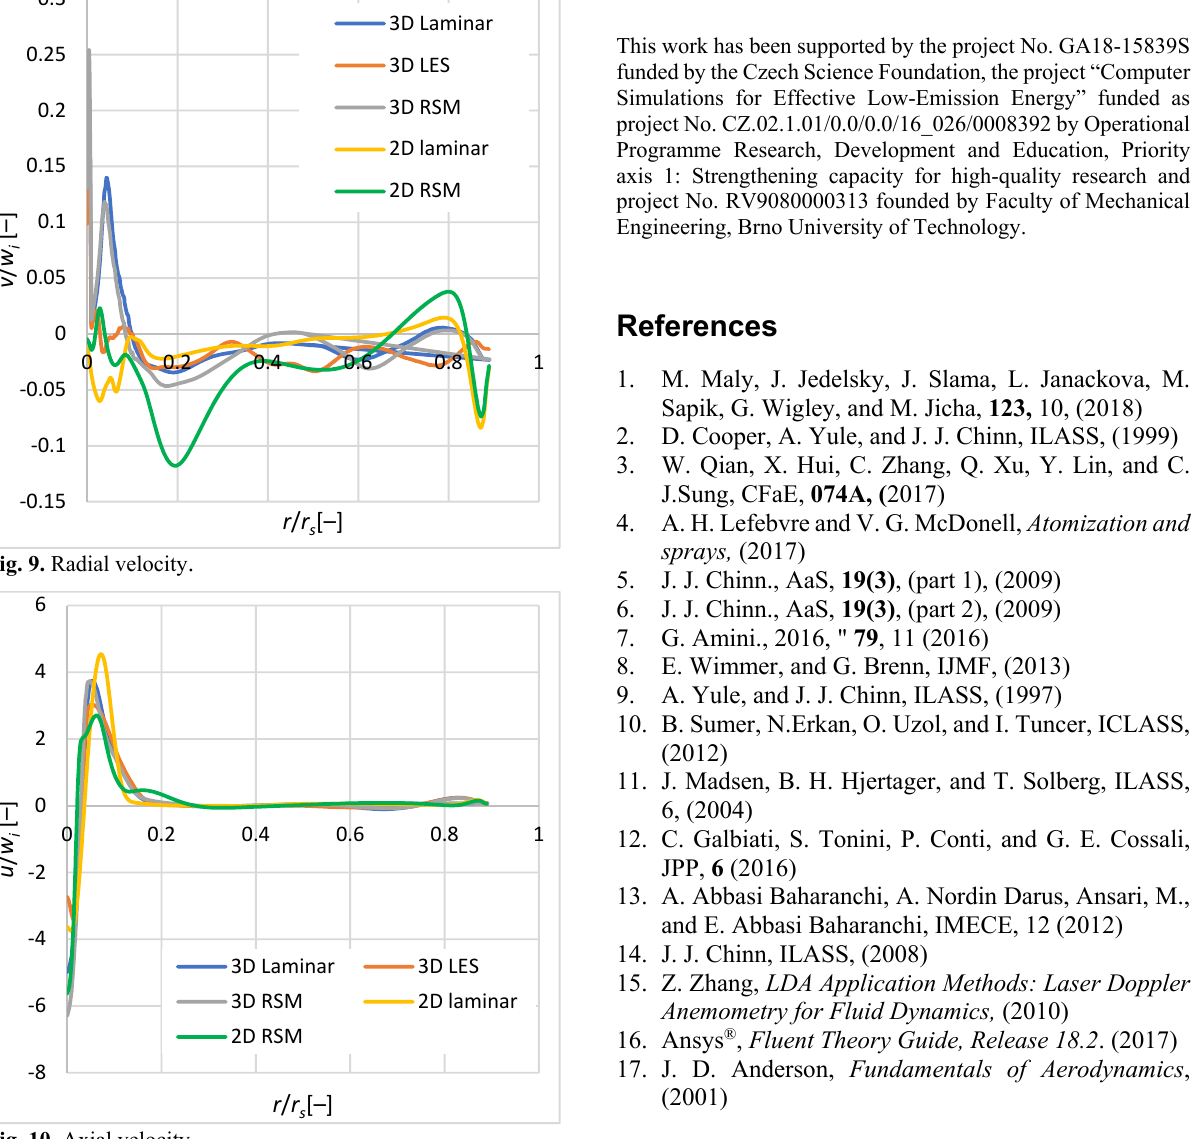
Fig. 8. Swirl velocity .